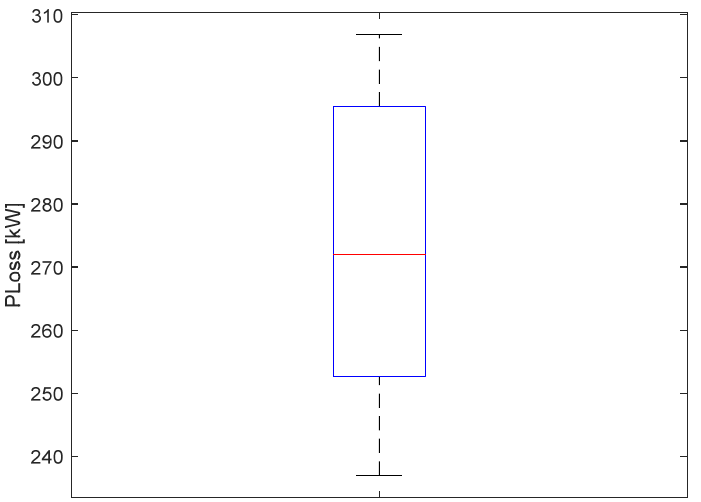
Figure 8. Dispersion of the MOAIS simulations, Case 1.